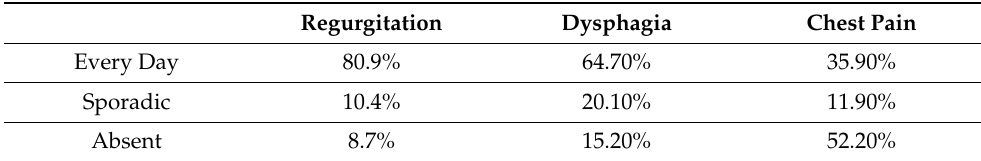
Table 3. Severity of symptoms at